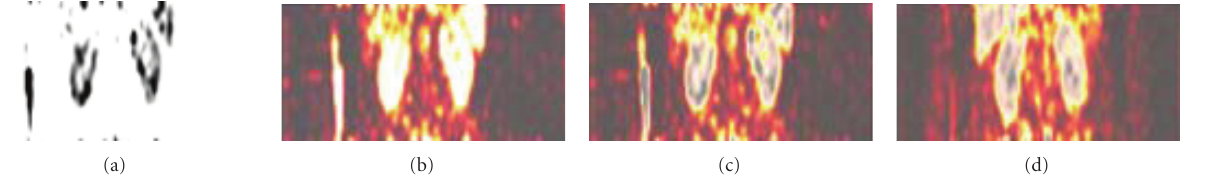
Figure 3: Images of kidney: (a)-(b) is one coronal section at 40–50 seconds, (c) is the fused image of (a) and (b), and (d) is another fused coronal section at 310–340 seconds.